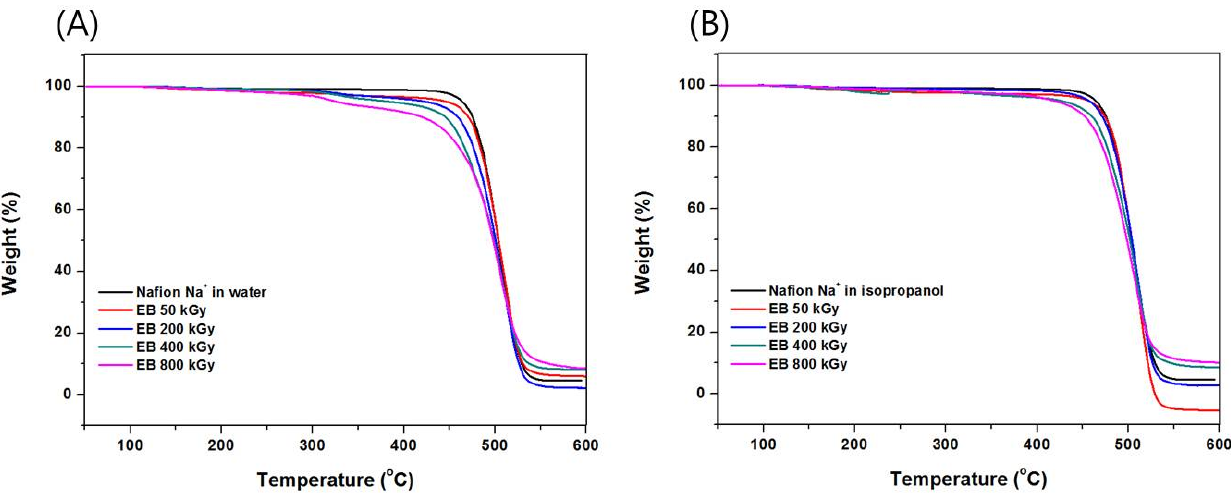
Figure 5. TG curves of EB-irradiated Nafion membranes with sodium form under a N 2 atmosphere: ( A ) in water; ( B ) in isopropanol solvent.